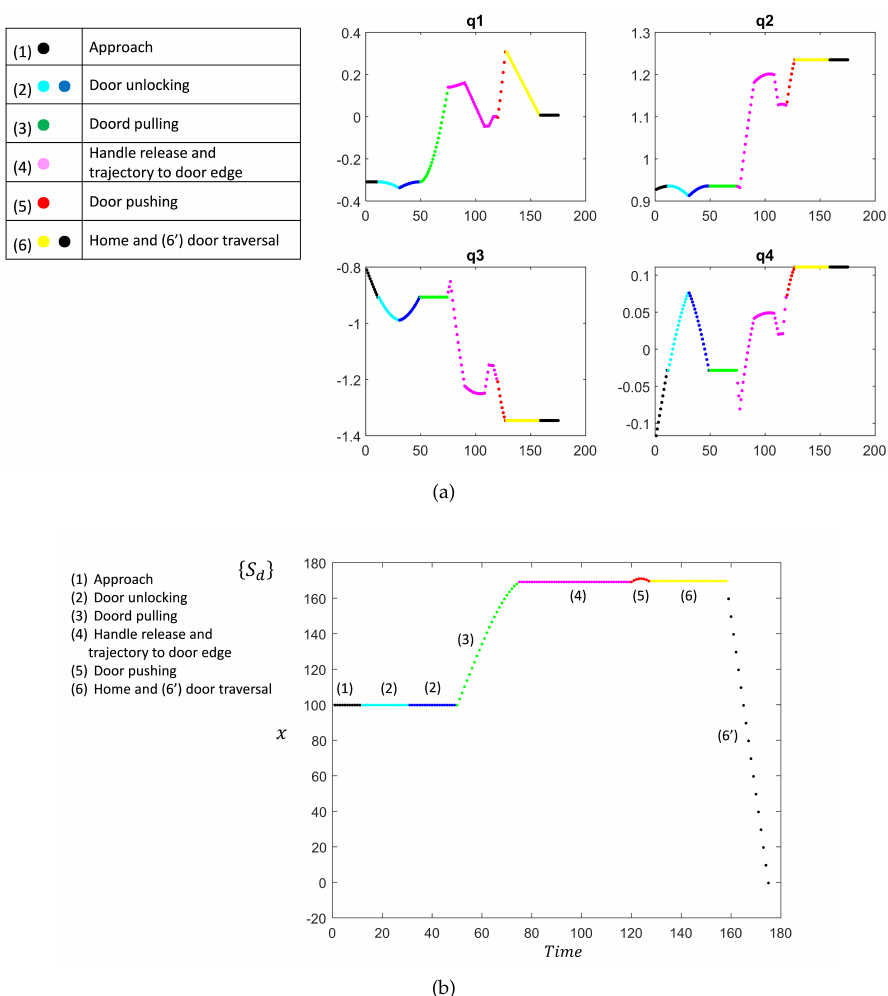
Figure 19. ( a ) Joint trajectories for different stages (in colours) in the door-opening process. Each stage is represented with a different colour. ( b ) MoPAD trajectory.